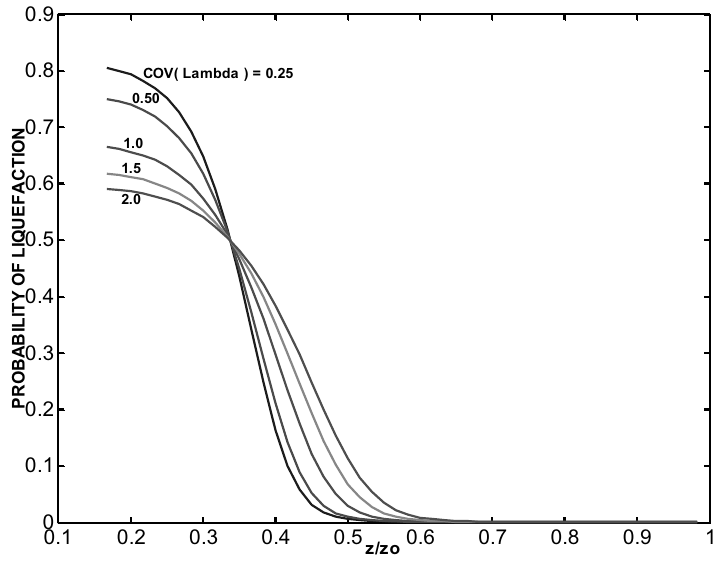
Fig. 7. Variation of the probability of liquefaction with the normalized depth (for several values of the coefficient of variation of the time-decay constant of the applied load). necessary simplifications for the intervening physical components were postulated to allow mathematical tractability of the